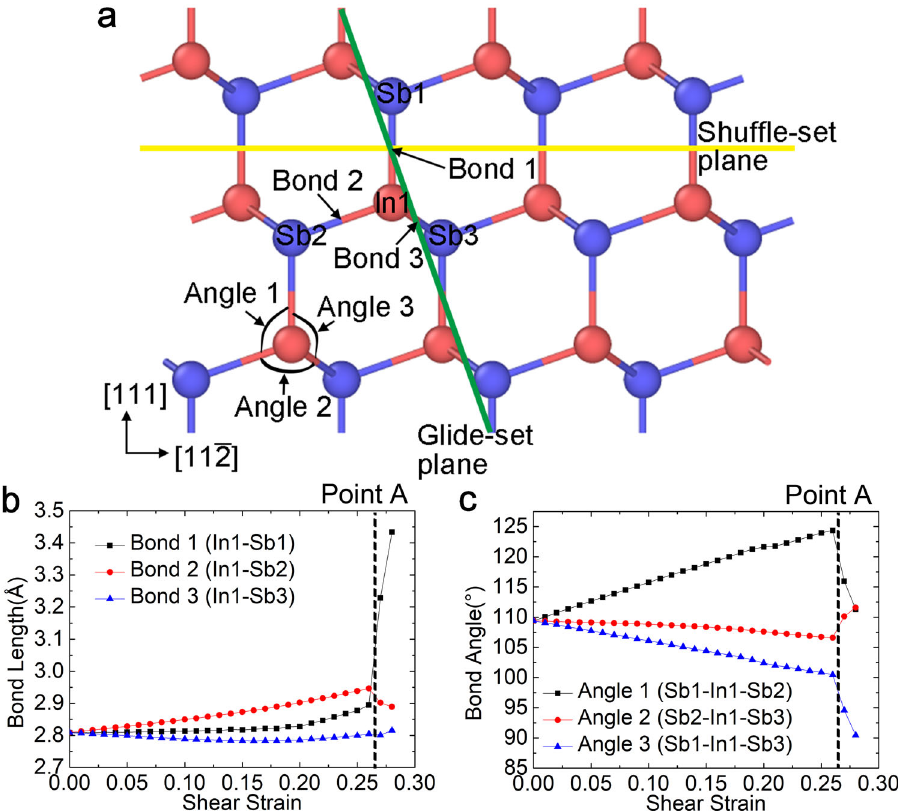
Fig. 6 Bond lengths and angles with increasing shear strain. a Schematic diagram of the bonds and angles, and the glide-set and shuf fl e-set planes. b Bond lengths with increasing shear strain. c Bond angles with increasing shear strain. The double fcc lattice has two different kinds of slip planes on {111}: glide-set plane (narrowly spaced atomic layer) and shuf fl e-set plane (widely spaced atomic layer) 44 . In a , the glide-set plane and shuf fl e-set plane are represented by the green line and the yellow line, respectively. In b and c , point A in Fig. 1b is represented by black dashed lines to distinguish the elastic and plastic stage.